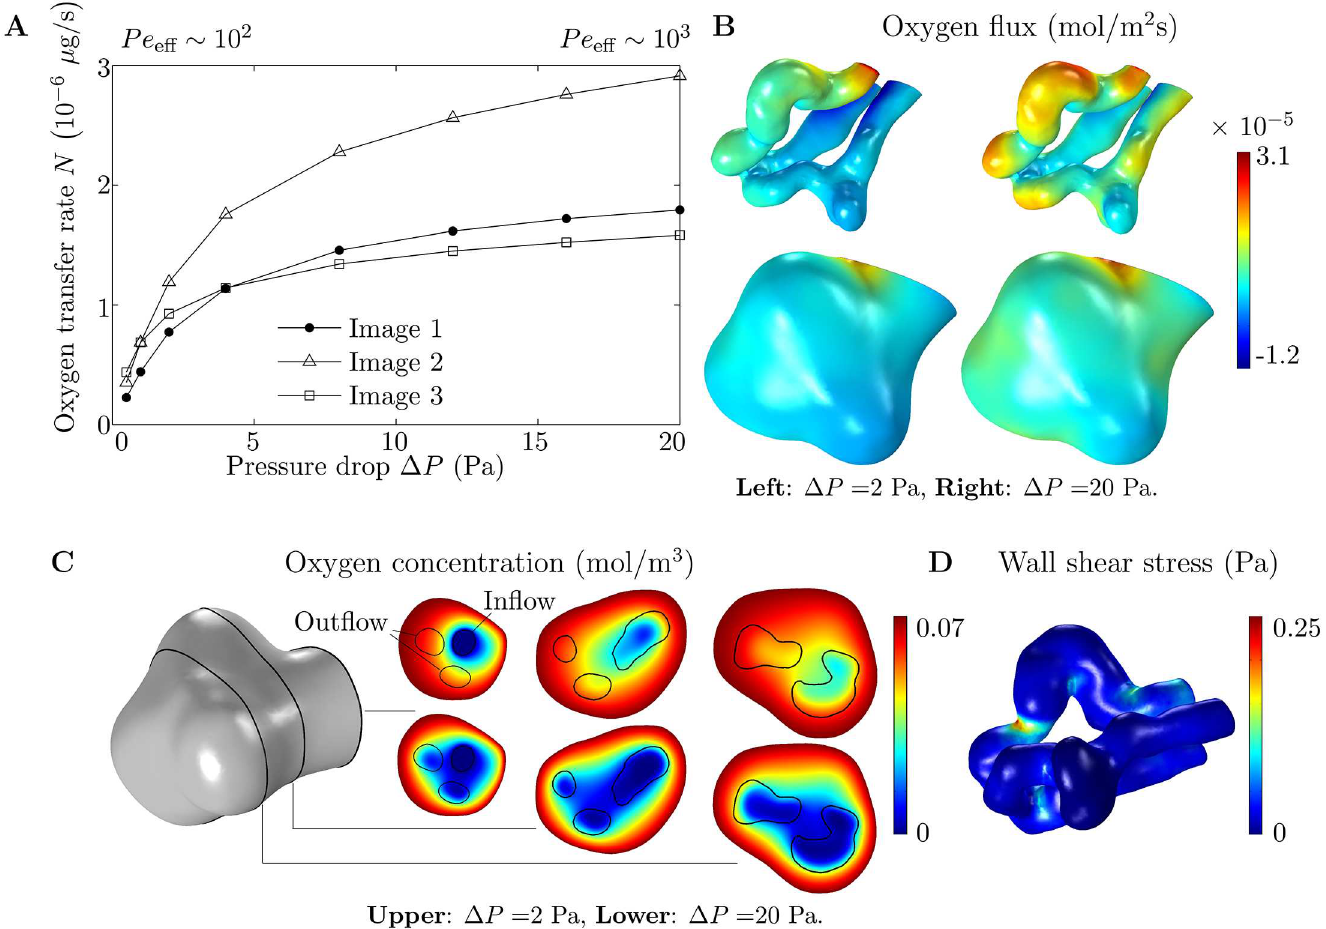
Fig 2. Results of numerical simulations on 3D geometries. (A) Oxygen flux enteringeach capillary versus pressure drop Δ P . The range of values of Δ P is broadlyphysiological, leadingto flow velocities of around 300 μ m/ s (Table 3), which is the approximate flow velocity in normal capillaries[36]. Pe eff is in the range 10 2 –10 3 as indicated. (B) Distributionof oxygen flux entering through the capillary (top) and villous (bottom) surfaces, from simulations on Image 1. Results are shown for Δ P = 2 Pa (left) and Δ P = 20 Pa (right). (C) Plots of the oxygen concentration field on three planes, 15 μ m apart, from simulations on Image 1. The planesare shown on the villous surface on the left. Results are given for Δ P = 2 Pa (top) and Δ P = 20 Pa (bottom). Capillary walls are denotedby black lines. The inflow and outflow capillaries are labeledon the plane at the villous entrance (left). (D) Wall shear stress at the capillary surface, from a simulation on Image 1 ( Δ P = 2